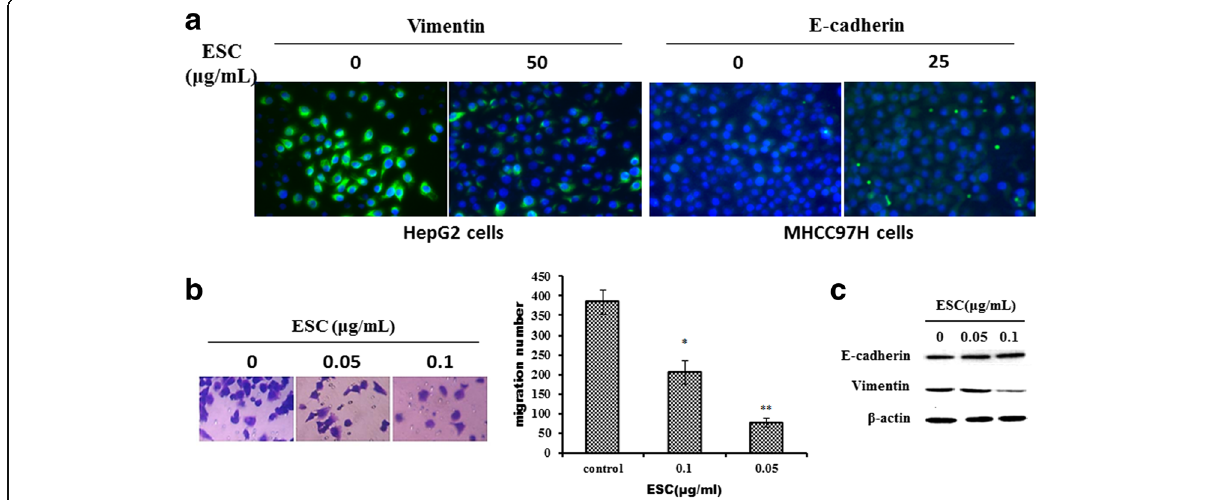
Fig. 2 EMT inhibition of ESC in HepG2 cells and MHCC97H cells. a Influence of ESC on Vimentin and E-cadherin expression in HepG2 cells and MHCC97H cells with immunofluorescence assay at 24 h. b Influence of ESC on MHCC97H cells migration with transwell assay at 24 h. c Influence of ESC on Vimentin and E-cadherin expression in MHCC97H cells with western blot method at 24 h. * p < 0.05, ** p < 0.01 vs